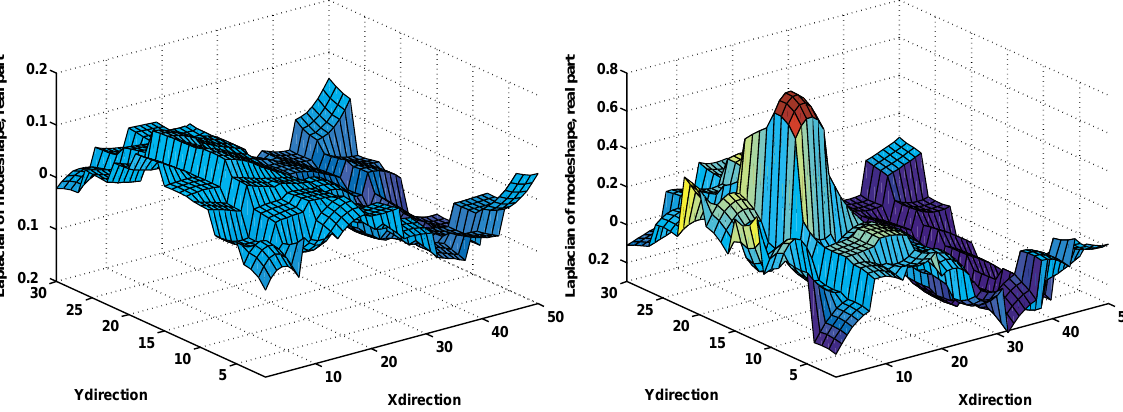
Fig. 10. Laplacians of the fifth mode shape extracted from measurements of an undamaged (left) and damaged (right) delaminated plate. The Laplacian is computed using differences of the spline approximation coefficients. shape, the area which contains the delamination is